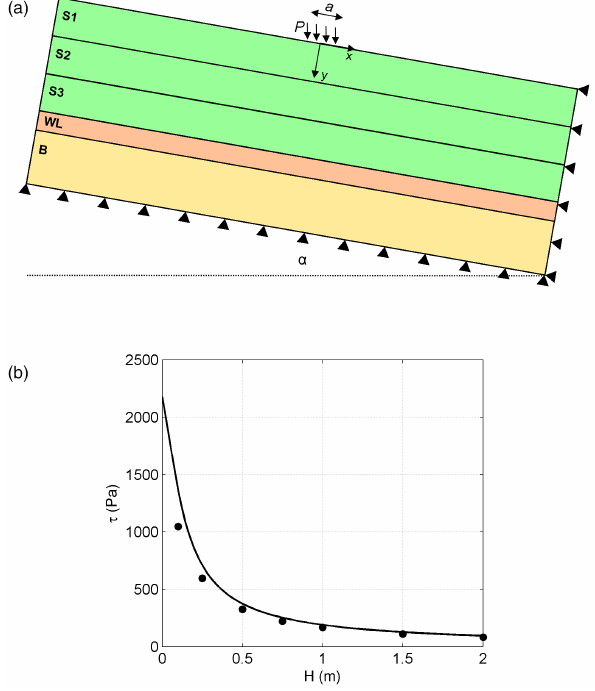
Figure 4. (a) FE model to simulate the maximum shear stress at the depth of the weak layer consisting of three slab layers (green), the weak layer (red) and a basal layer below (orange) inclined by the slope angle α . Triangles indicate fixed nodes. The applied strip load P is illustrated by black arrows pointing towards the snow sur- face. The axes of the coordinate system are indicated by arrows. (b) Maximum shear stress from FE simulations (dots) and from the analytical solution (line) for a uniform slab with density 200kgm − 3 and a slope angle of 38 ◦ vs. slab thickness H .